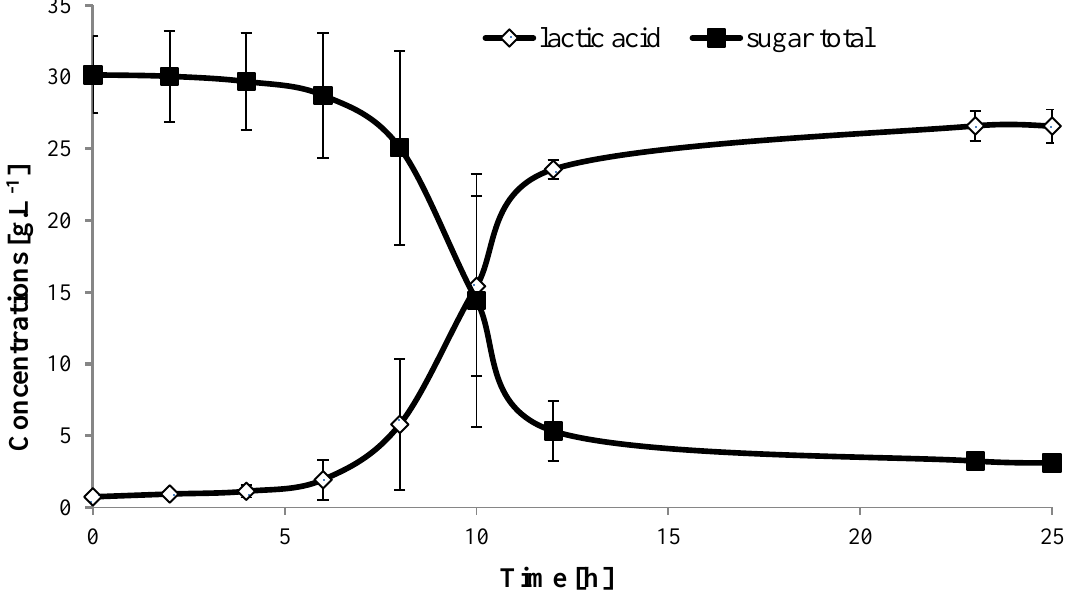
Figure 1. Lactic acid production and remaining sugars trend during 25 h fermentation after hydrolysis of banana peduncles biomass (15% DM) using isolate A166. Each data point represents the mean of 3 replicates ± SD.